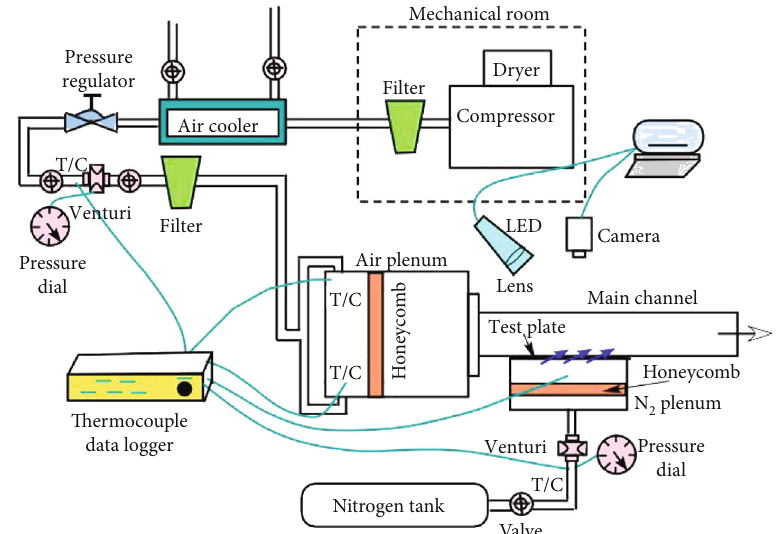
Figure 1: Test rig, associated accessories, and data collection equipment.